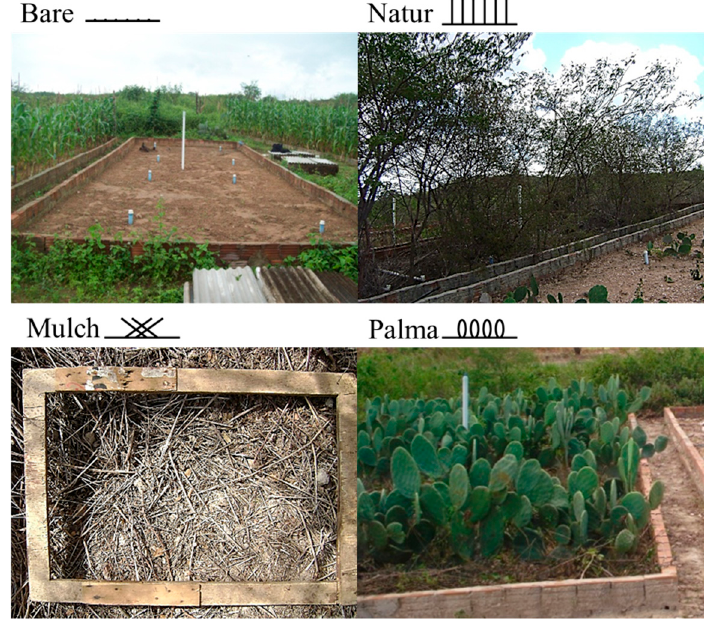
Figure 2. Photographs of the experimental plots for the different cover conditions (plot with bare soil—Bare; plot with natural cover—Natur; plot with mulch—Mulch; and plot with Cactus Palma).